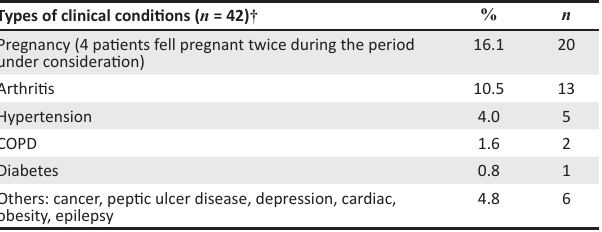
TABLE 2: Concurrent clinical conditions.